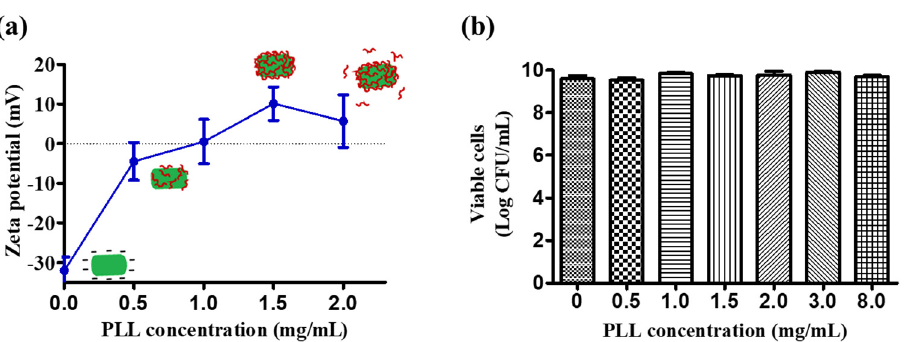
Figure 1. Optimization of the PLL coating on the surface of Lactobacillus plantarum. ( a ) Zeta potential of L. plantarum after coating with different concentrations of the PLL solution. ( b ) Viability of L. plantarum after incubation with different concentrations of the PLL solution for 15 min. The error bar represents the standard deviation ( n = 5).